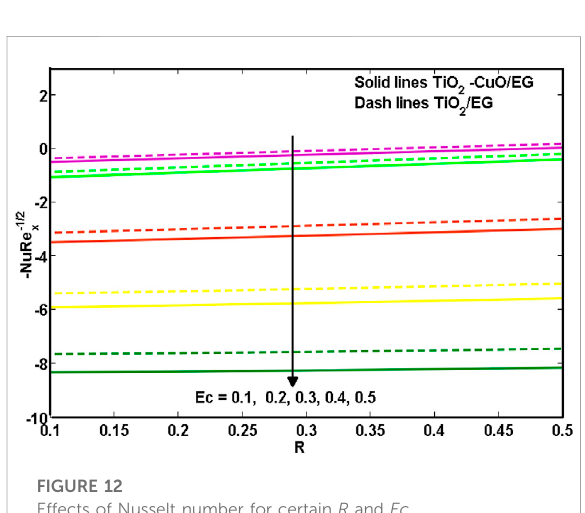
FIGURE 11 Effects of Nusselt number for certain R and β .